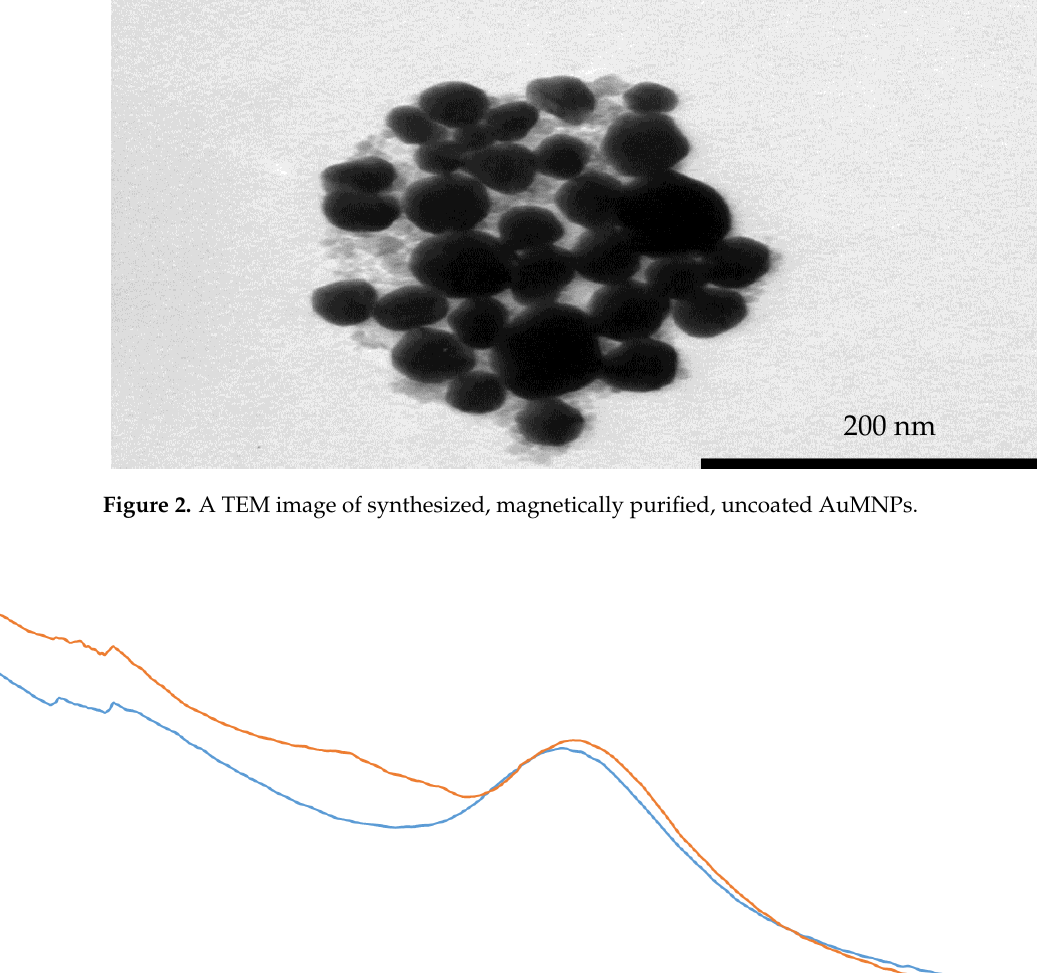
Figure 2. A TEM image of synthesized, magnetically purified, uncoated AuMNPs.